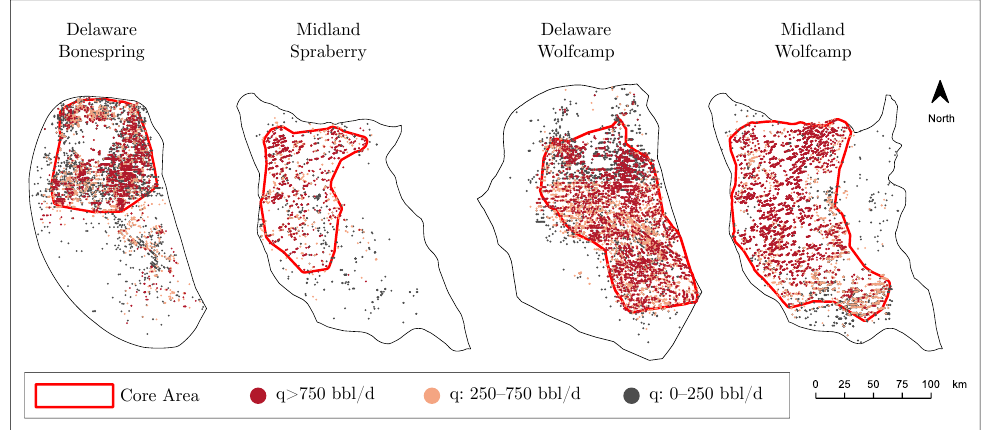
Figure 2. Production data-driven definition of core and noncore areas for the four Permian tight reservoirs: Delaware Bonespring, Midland Spraberry, Delaware Wolfcamp, and Midland Wolfcamp. The outer outline was obtained from USGS and is consistent with Figure 1.